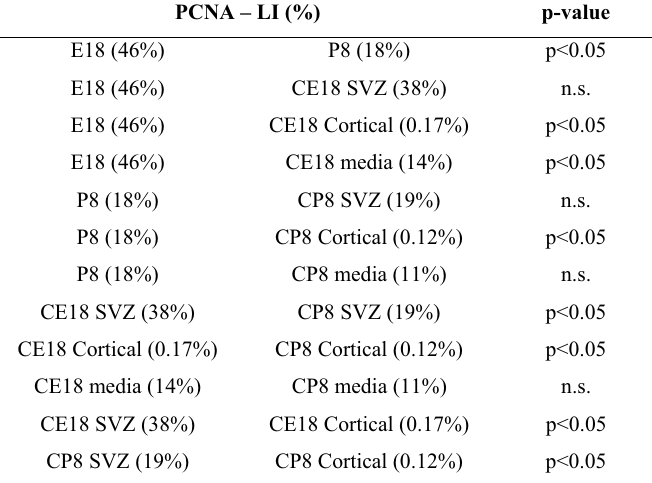
TABLE 1 - PCNA labeling index in fetal and neonatal control brain and in fetal and neonatal heterotopic brain tissue in the lung